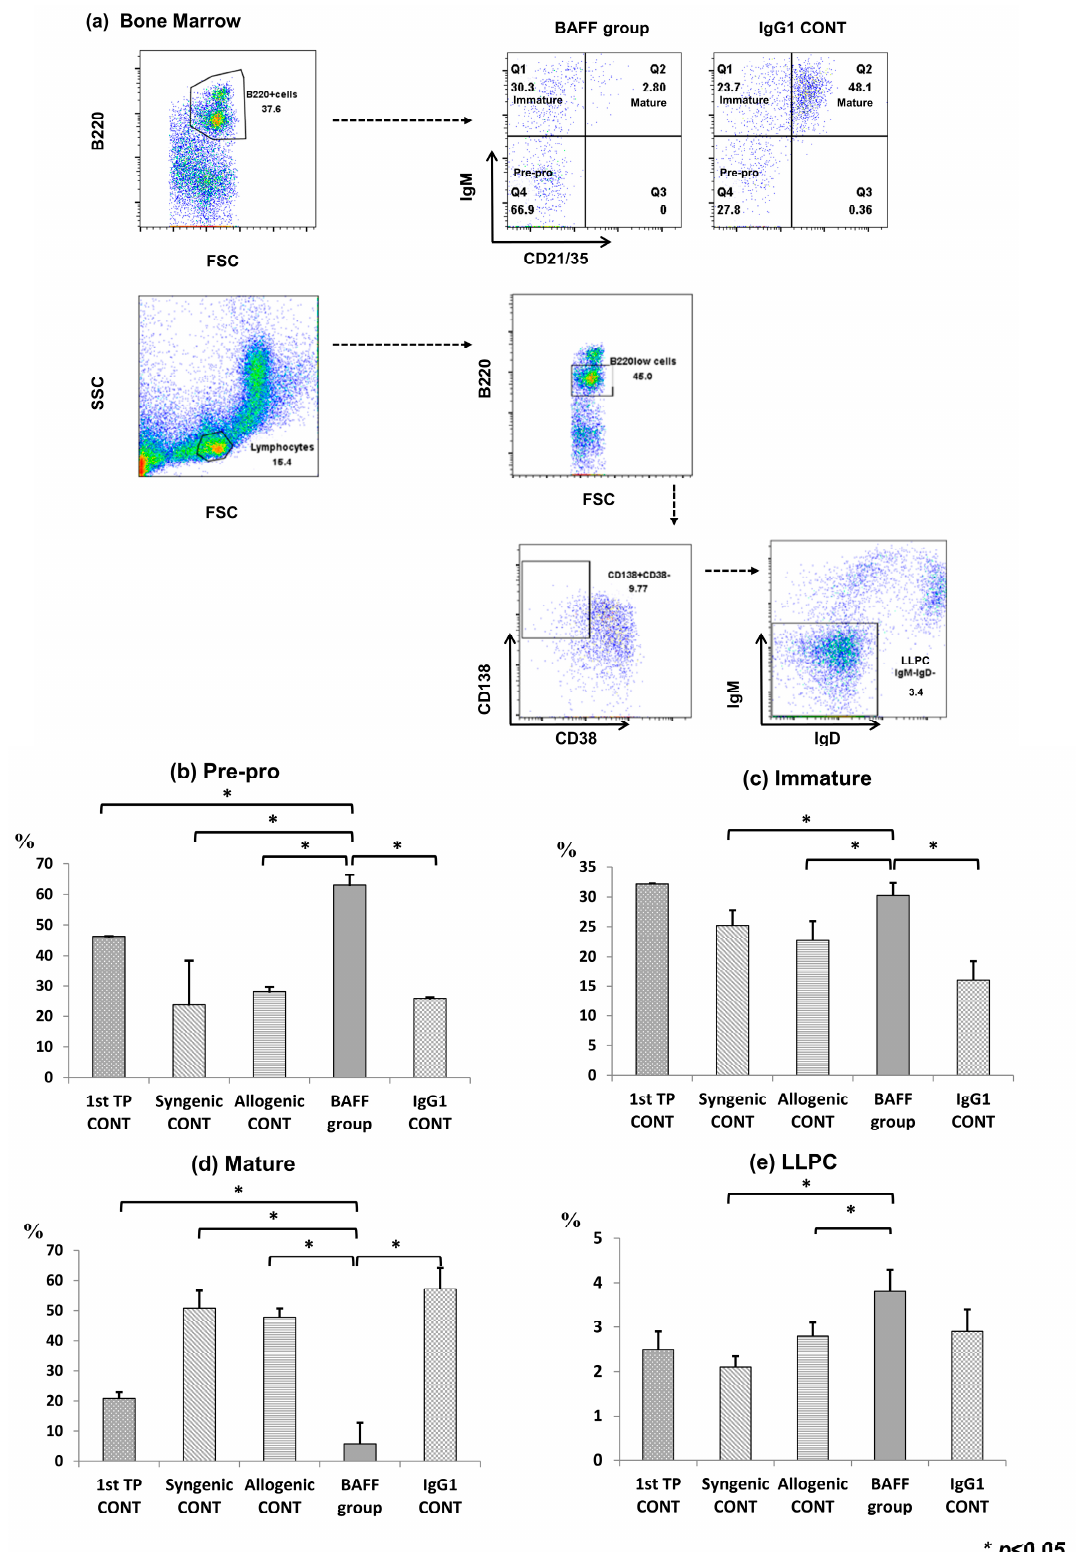
Figure 2. B cell population at week 9 (4 weeks after second transplantation) in the recipient bone marrow analyzed using flow cytometry. ( a ) Gating strategy, ( b ) fractions of B220+CD21/CD35-IgM-pre-pro B cells, ( c ) B220 + CD21/CD35-IgM+immature B cells, ( d ) B220 + CD21/CD35 + IgM+ mature B cells, and ( e ) B220lowCD138 + CD38low(Ig–) long lived plasma cells (LLPC). Error bars represent 2 standard errors (SE).